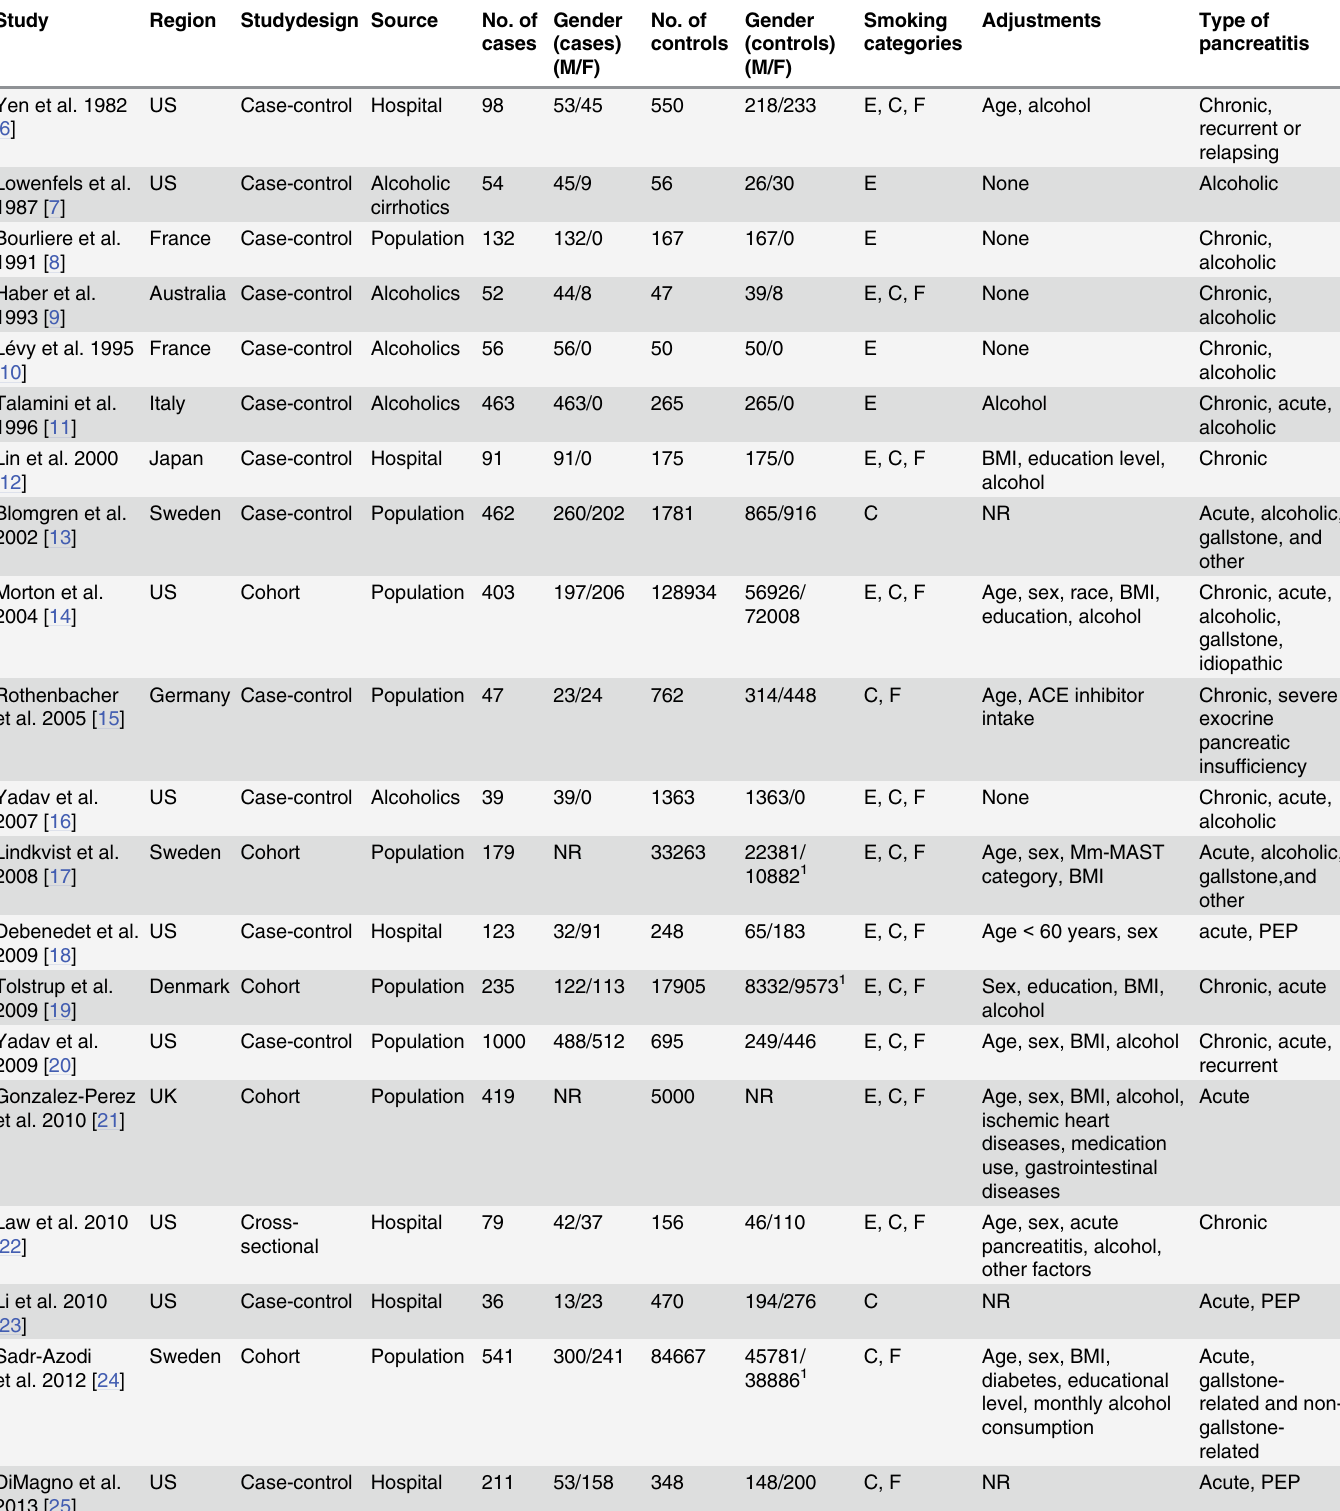
Table 1. Characteristics of studies included in the